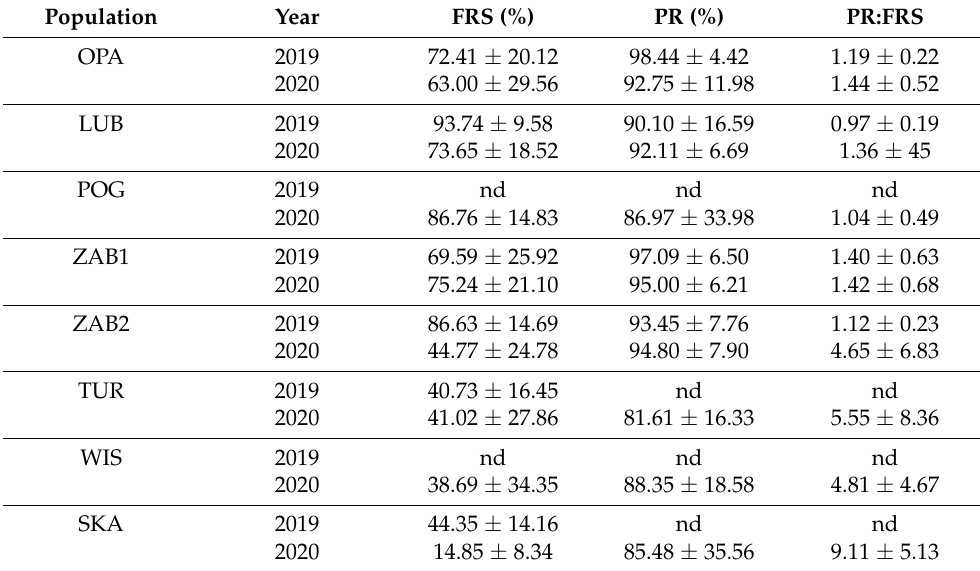
Table 7. Spatial and temporal variation of FRS and PR in Neottia ovata populations. Data show the mean ± standard